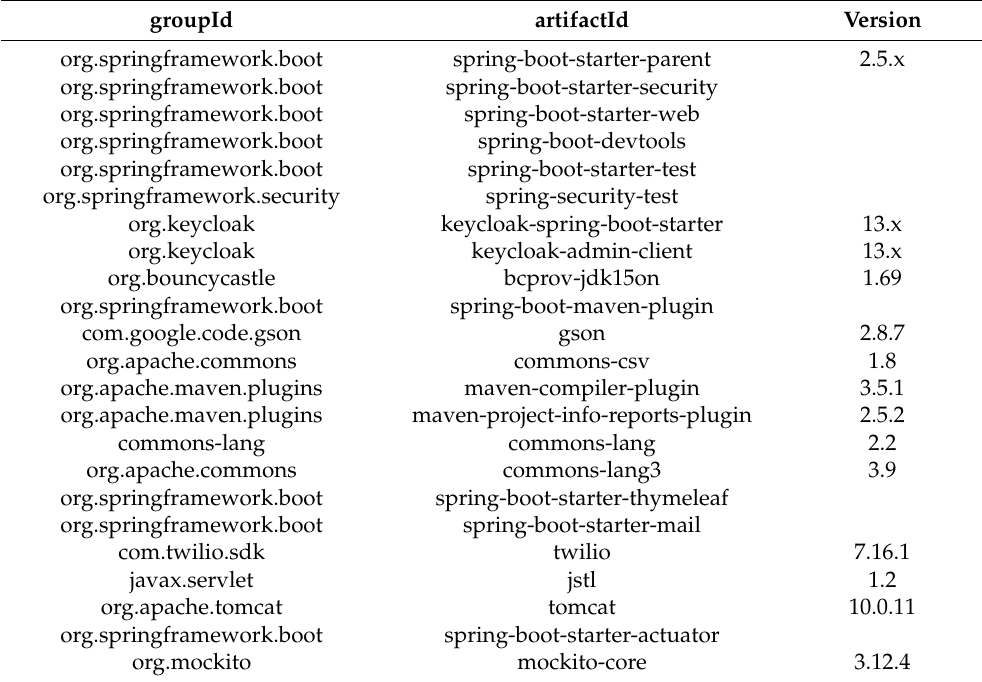
Table 5. Scoped libraries and respective version.